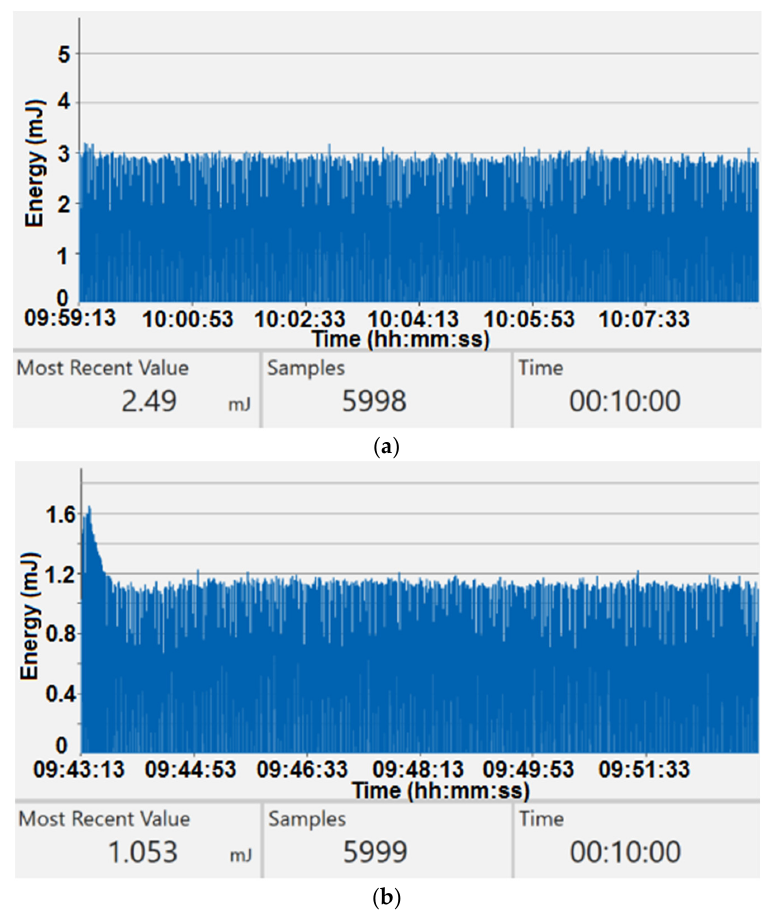
Figure 14. Stability of the laser radiation pulse output energy of the airborne lidar in the methane sounding informative wavelength range: ( а ) 2916.55–2917 cm −1 on-line; ( b ) 2915.00 cm −1 off-line.